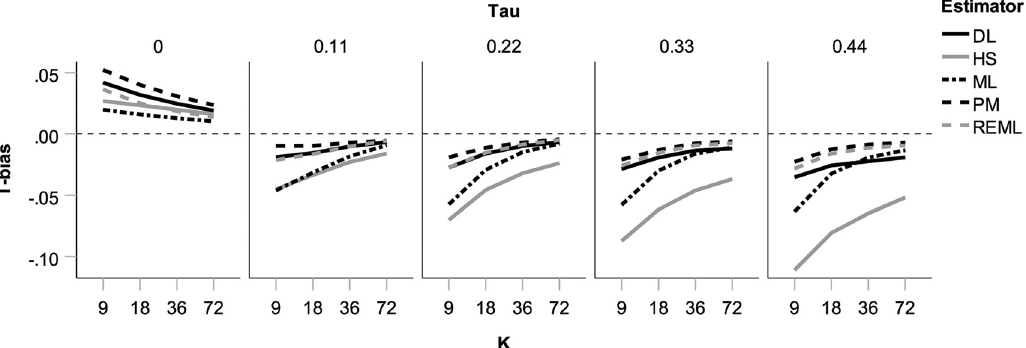
Fig 2. Bias in heterogeneity estimates (Tbias) in the absence of publication bias and p-hacking for five heterogeneity estimators as a function of true heterogeneity ( τ ) and number of studies in the meta-analysis ( k ).